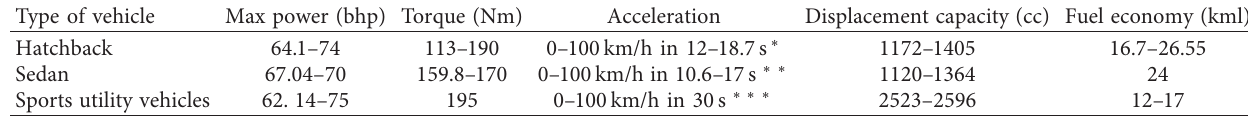
Table 5: Performance indicators for passenger car.